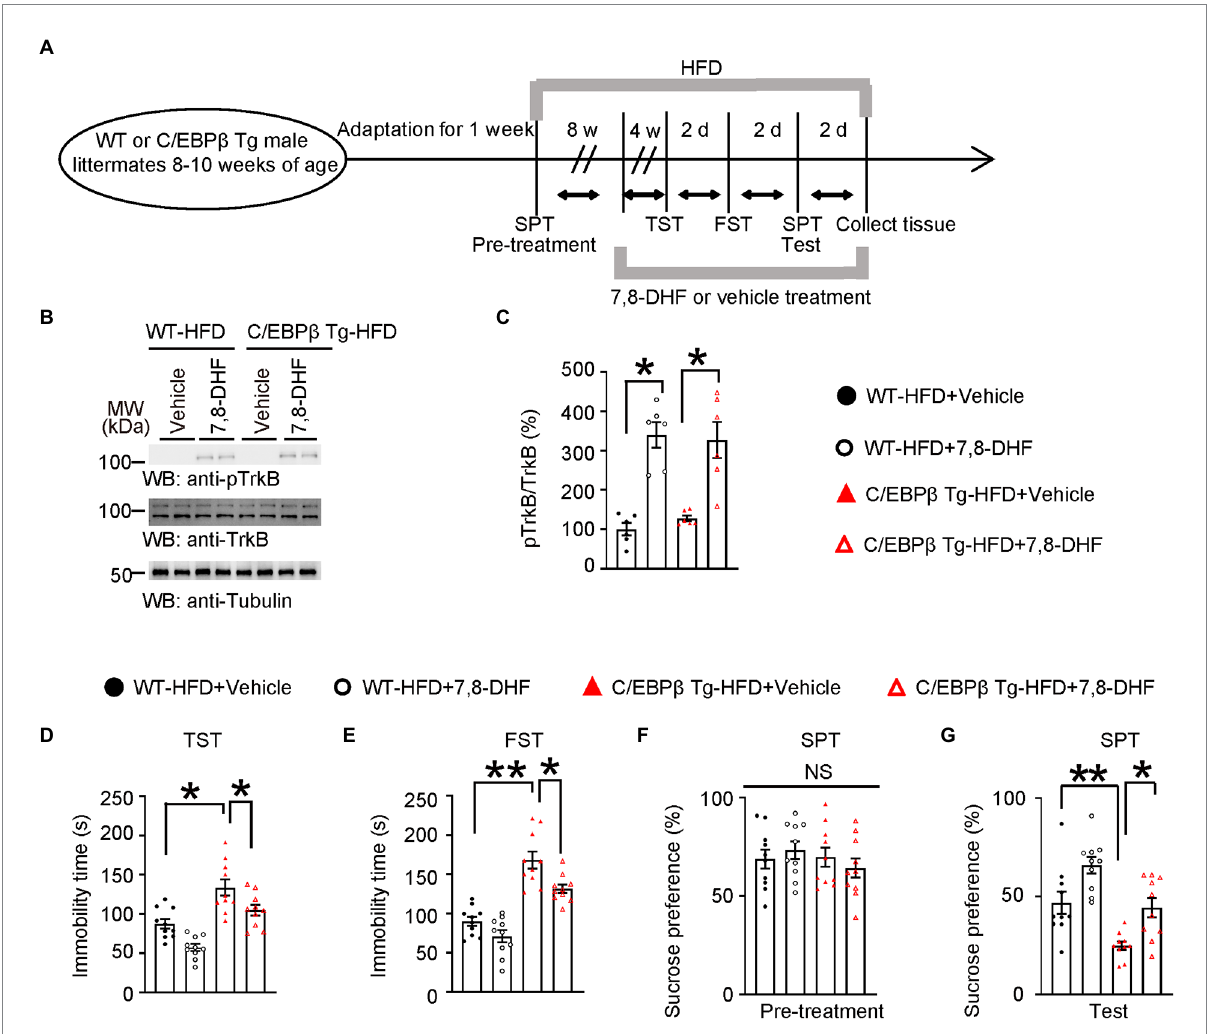
FIGURE 8 7,8-DHF alleviates HFD-induced depression-like behaviors in Thy1-C/EBP β Tg mice. (A) Schematic of the HFD and chow diet, 7,8-DHF and vehicle treatment, and behavioral tests process in wild-type and Thy1-C/EBP β Tg male mice. (B) Representative immunoblots and (C) quantification of pTrkB and TrkB protein expression in the hippocampus of the above mice after 7,8-DHF or vehicle treatment. Data in (B) are representative of three independent experiments. Data in (C) represent the mean ± SEM ( n = 6 for each group; ** p < 0.01; one-way ANOVA and Bonferroni’s